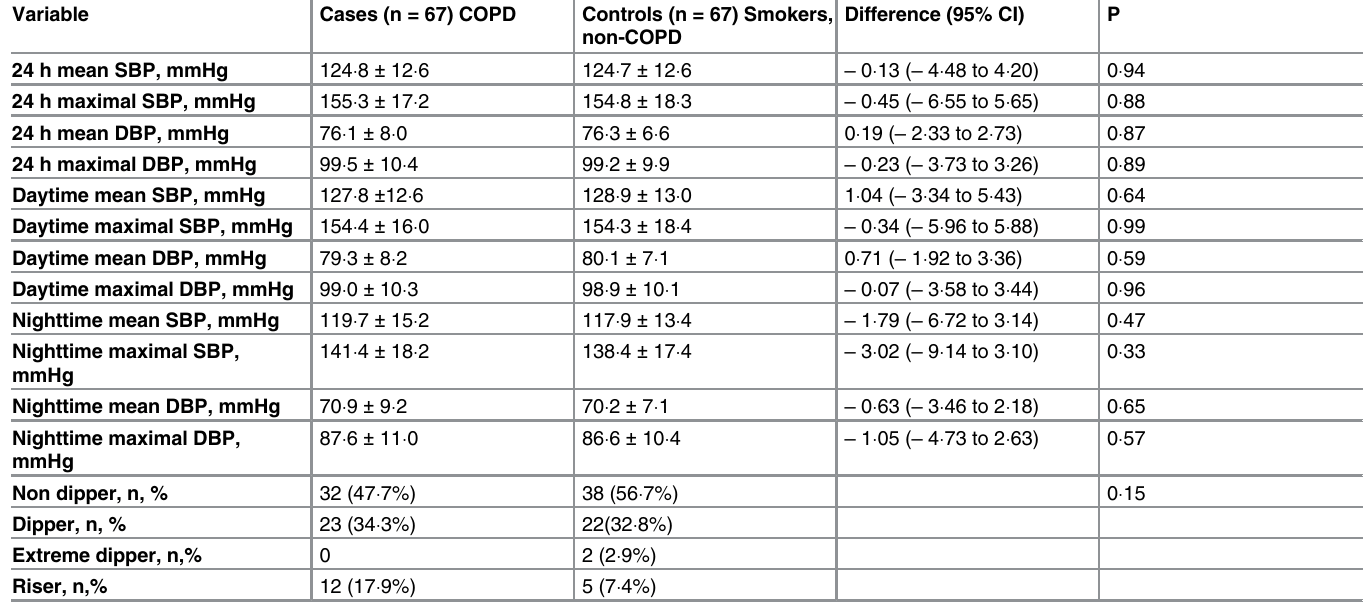
Table 2. Results of the ambulatory blood pressure